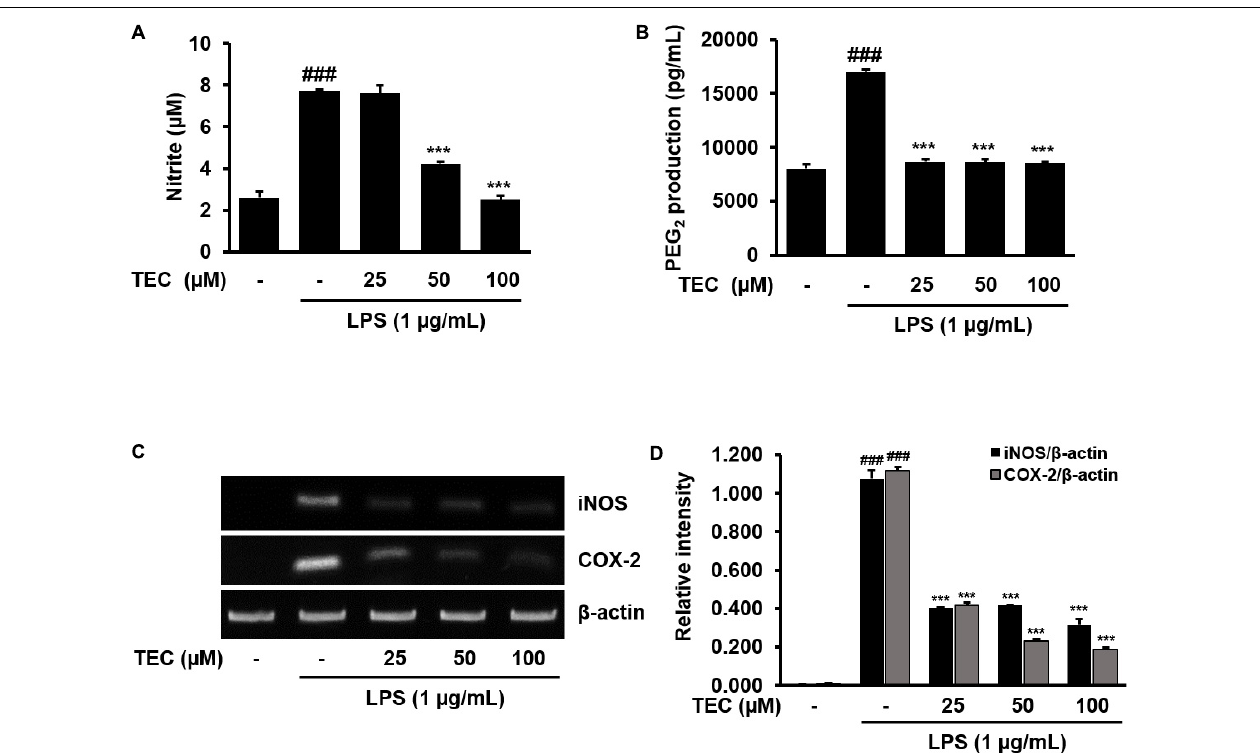
FIGURE 2 | TEC inhibits the production and expression of inflammatory molecules in LPS-stimulated BV-2 microglia. Cells were pre-treated with TEC for 2 h followed by LPS stimulation (1 µ g/mL) for 22 h. The supernatants are obtained and the amount of (A) nitrite and (B) PGE 2 released into the media is determined. (C) Cells were pretreated with TEC for 1 h followed by LPS stimulation for 5 h and then RT-PCR was performed to see the effects of TEC on mRNA expression of iNOS and COX-2. (D) Bar graphs represent the relative expression of iNOS and COX-2 for (C) . The results are expressed as the mean ± SEM of three independent experiments. ### P < 0.001 vs. untreated control cells and ∗∗∗ P < 0.001 vs. LPS-treated